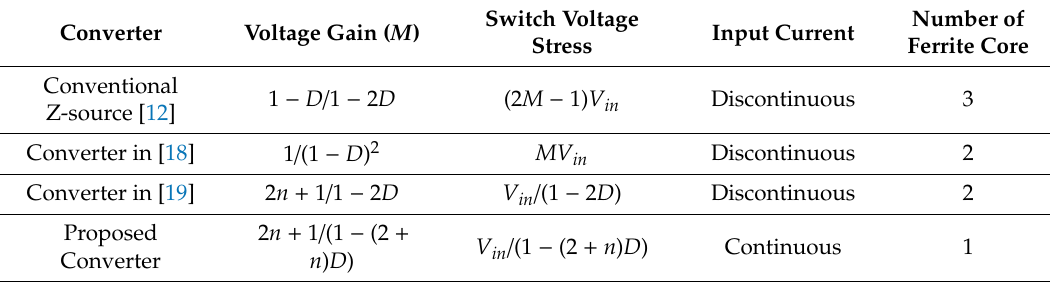
Table 1. Comparison of proposed converter with other Z-source DC–DC converters.